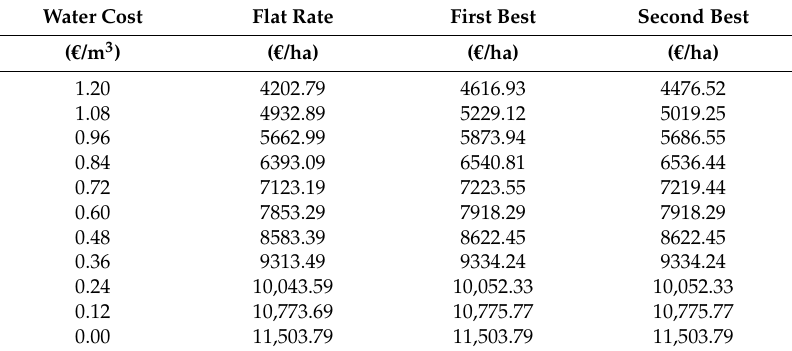
Table 4. Range of social benefits as water costs increase z ( q i )